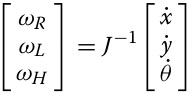
Using J , the velocity of the right and left wheels and the rotation axis ω R , ω L , ω H is determined from the velocity of the body ˙ x , ˙ y , θ as represented in the following.